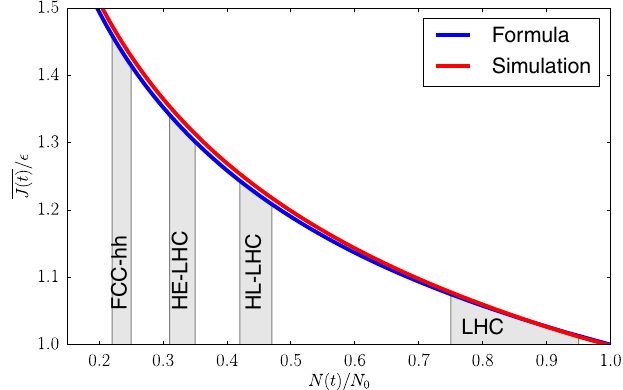
FIG. 3. Relative emittance growth versus remaining bunch intensity from analytical formula in Eq. (17) and simulations considering only one transverse dimension. Shaded regions indicate typical or expected relative intensities after a physics fill.